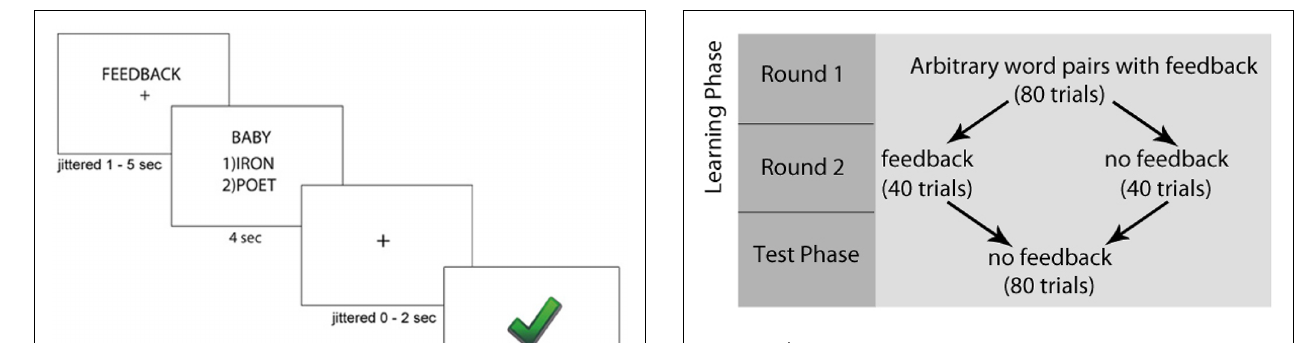
FIGURE 2 | Paired-Association Word Learning Task Experimental Design. Participants completed two rounds of the learning phase, followed by the test phase. In the first round of the learning phase, word matches were arbitrary, but participants received feedback for all trials and were told to use this feedback for future rounds. After completing both rounds of the learning phase, participants completed the “test phase,” which asked participants